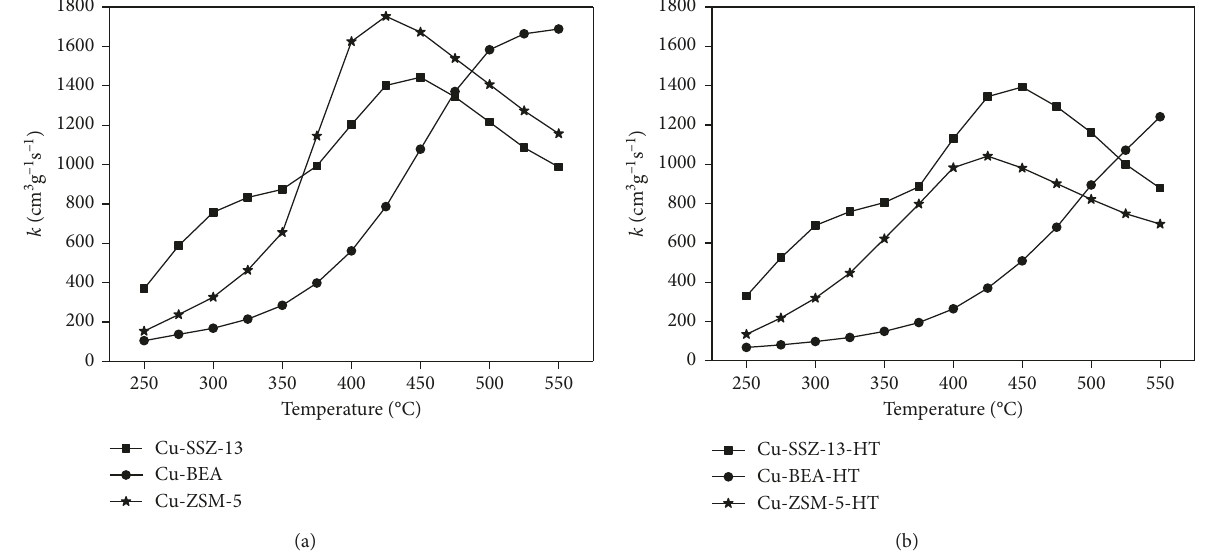
Figure 4: SCR activity of (a) fresh and (b) hydrothermally treated